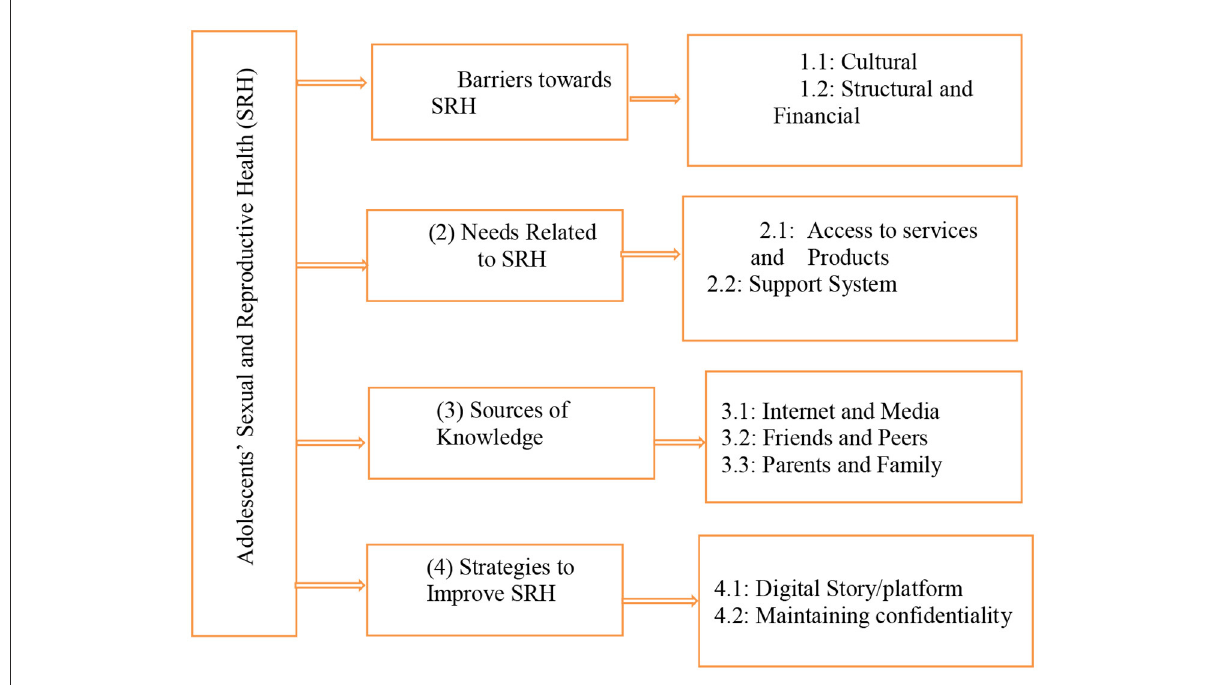
FIGURE1 Thematic framework on findings from adolescents’